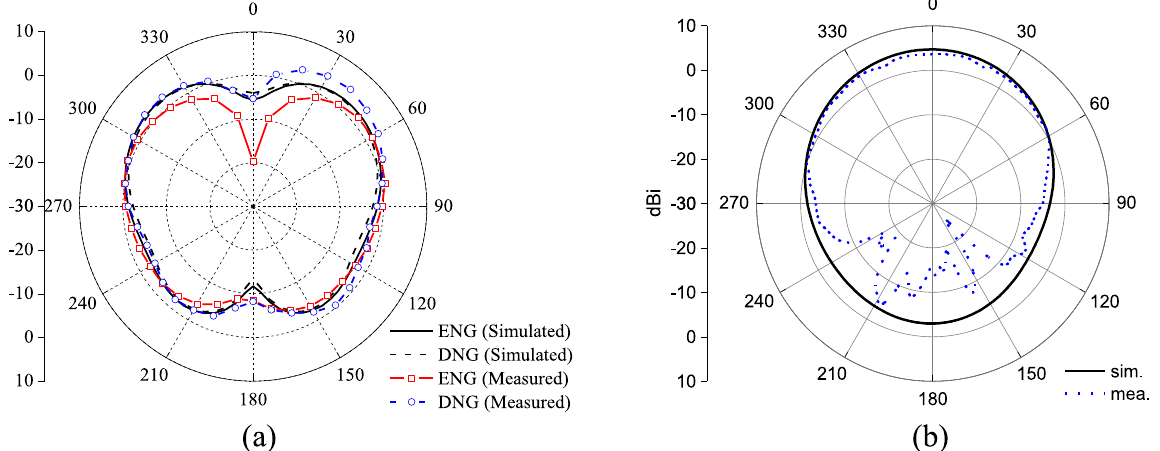
Fig. 4. The simulated and measured far- fi eld radiation patterns of (a) DNG and ENG ZOR antennas ( E -plane) [16] and (b) MNG ZOR antenna ( E -plane) [17].